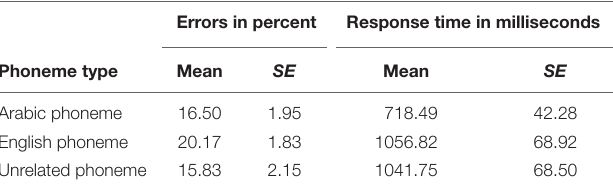
TABLE 3 | Mean error rates in percent and response times in milliseconds for Arabic monolinguals by condition in Experiment 2. Errors in